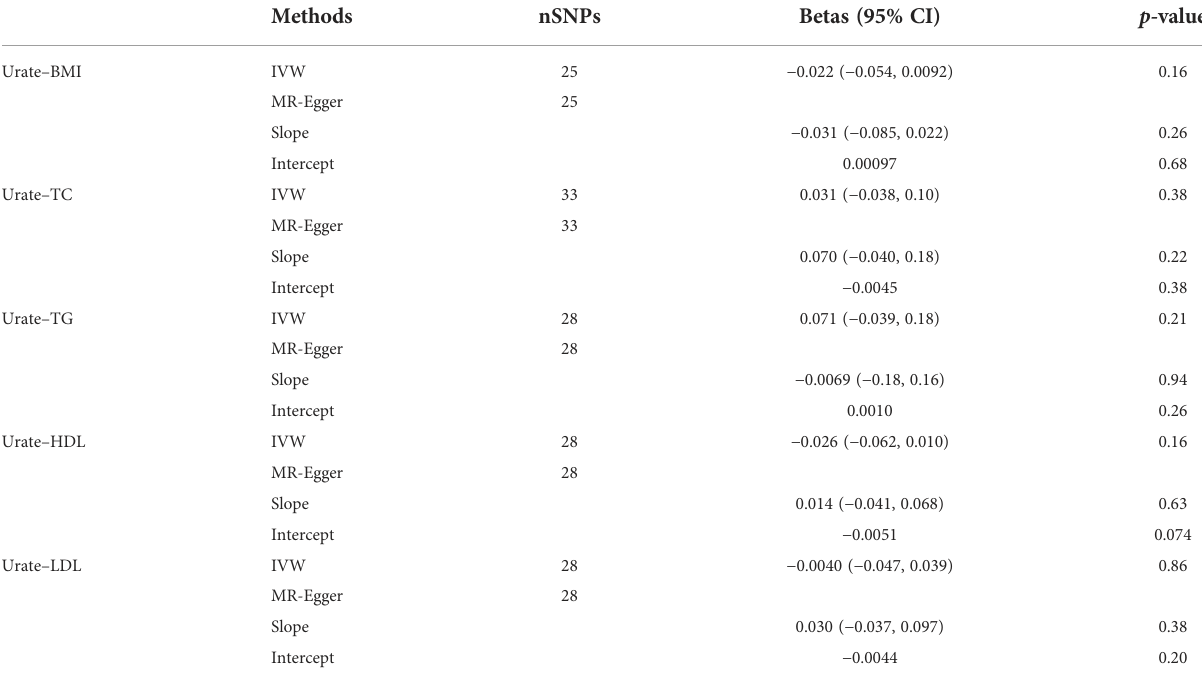
TABLE 6 The results of reverse